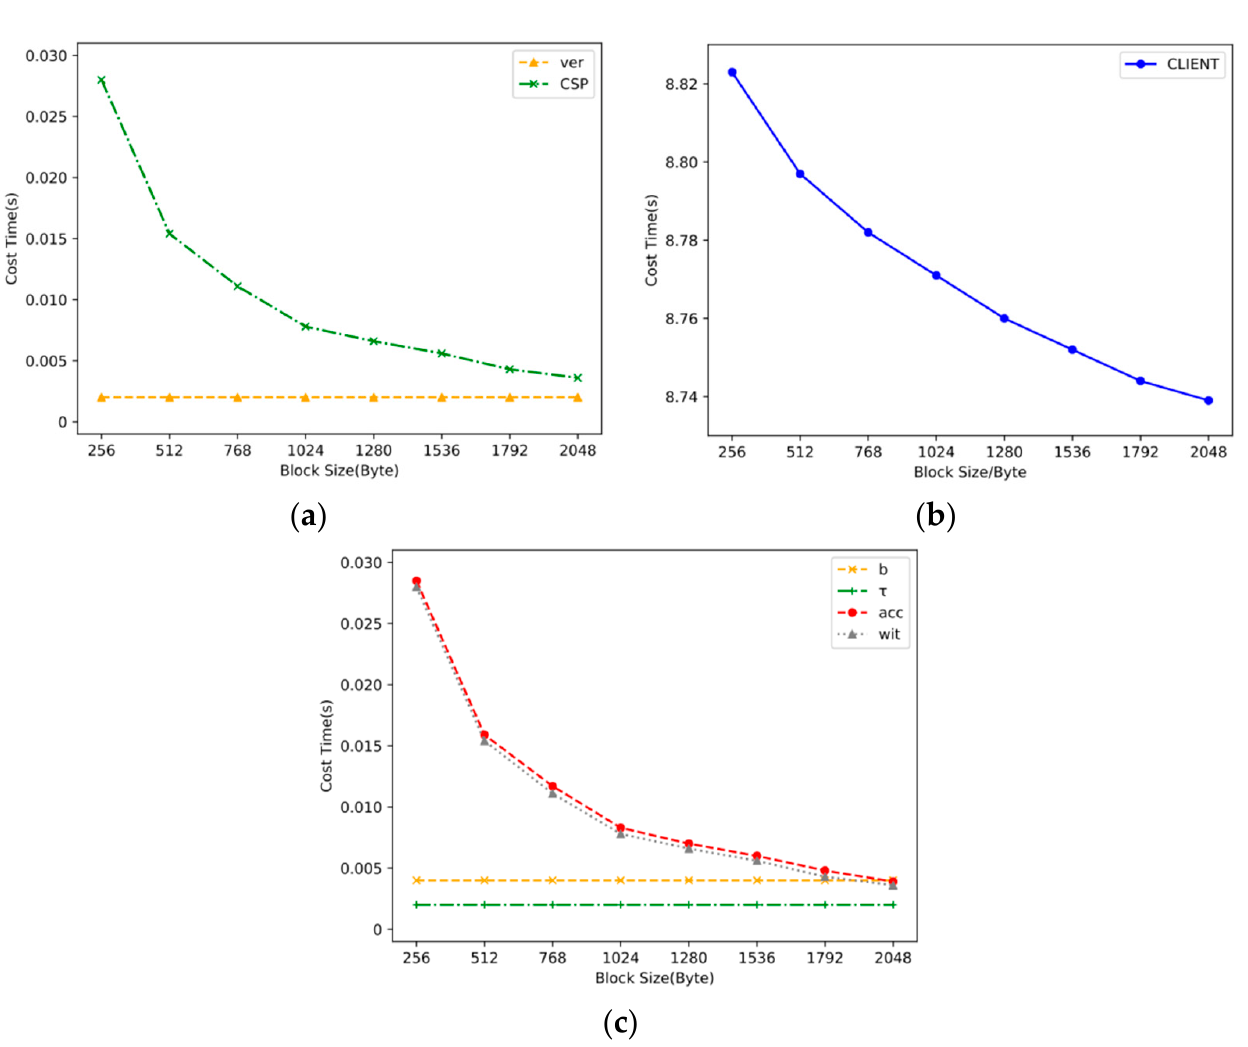
Figure 5. Computing overhead based on different block sizes. ( a ) Computing overhead of audit participants. ( b ) Computing overhead of the client. ( c ) Computing overhead of the parameters.